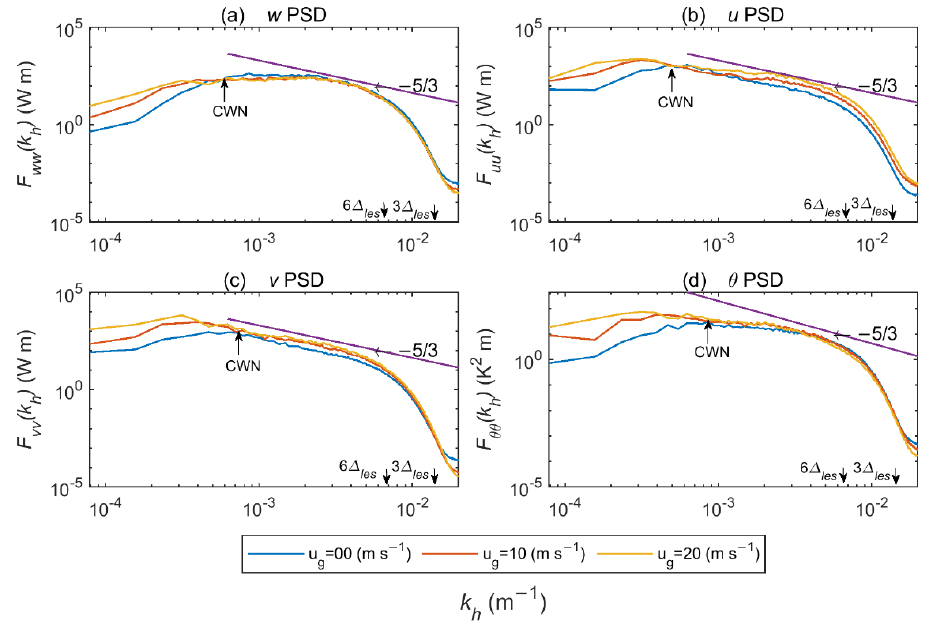
Figure 10. As in Figure 9 at z / z i =